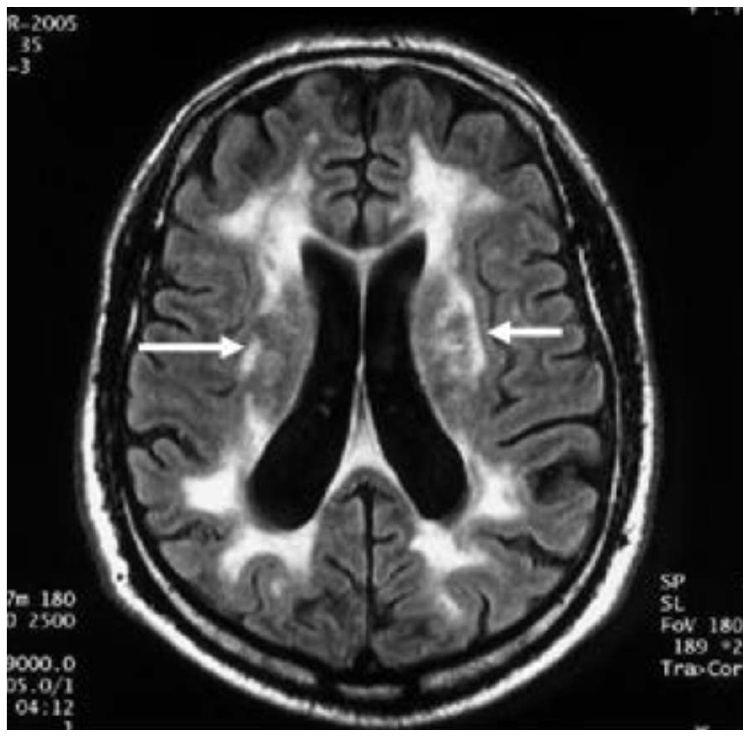
MRI brain scan of our patient (FLAIR images). Involvement of the external capsule can be